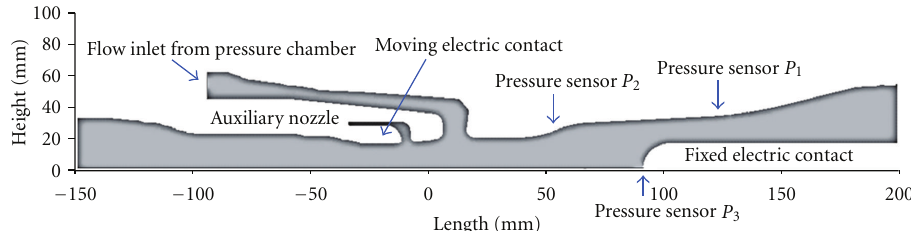
Figure 8: The illustrative sketch of the main flow region of the tested high-voltage circuit breaker and the locations of the three pressure sensors.